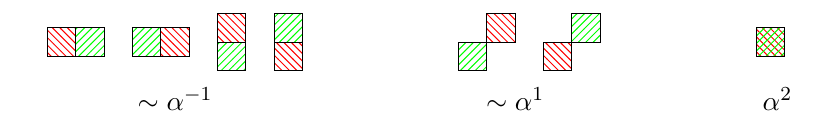
Figure 9 . Zeroes and poles coming from